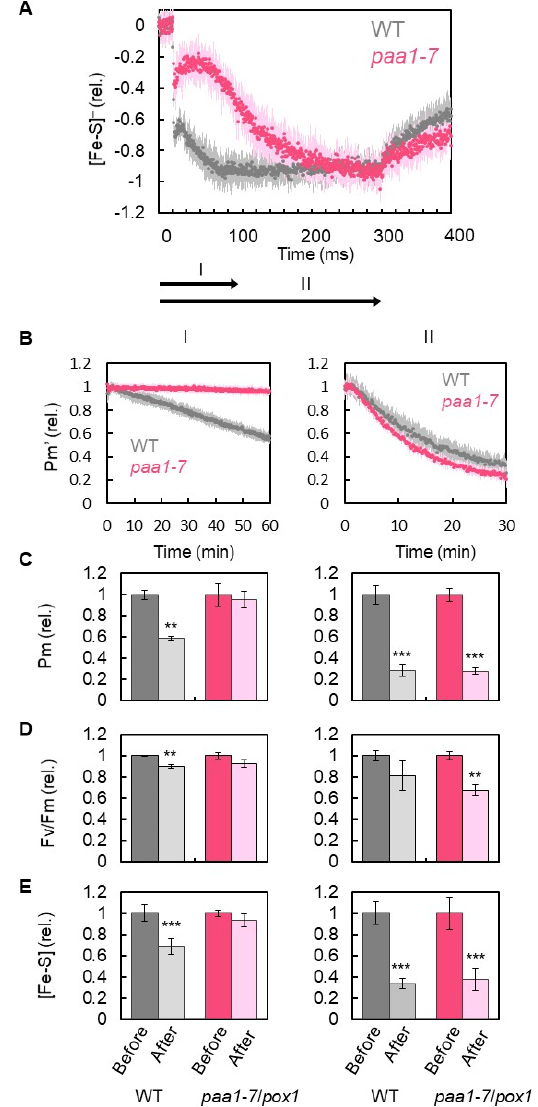
Figure 3. Effects of rSP light illumination and illumination time on the incident photo-oxidizable P700 (Pm’), photo-oxidizable P700 (Pm), maximum quantum efficiency of PSII (Fv/Fm), and amount of Fe/S in wild-type (WT) and paa1-7/pox1 Arabidopsis. The leaves were illuminated every 10 s with short-pulse light of 15,000 µ mol photons m − 2 s − 1 under atmospheric conditions (40 Pa CO 2 / 21 kPa O 2 ) for 30 min. The rSP light illumination started at 0 min. ( A ) The illumination time was set to the two durations, as indicated by the arrows (I, 100 ms; II, 300 ms), based on the reduction kinetics of Fe/S of both WT and paa1-7/pox1 (redrawn from Figure 1, Black, WT; red, paa1-7/pox1 ). In experiments I and II, the parameters Pm’, Pm, Fv/Fm, and [Fe/S] − were analyzed. ( B ) Pm’. Black, WT; magenta, pgr5 hope1 . The values were normalized to the primary values before the rSP light illumination treatment and are shown with standard deviations. The data were obtained from six biological replicates. ( C ) Pm, ( D ) Fv/Fm, and ( E ) Fe/S before and after the rSP light illumination treatments in both WT and pgr5 hope1 were compared. These parameters were evaluated after the illuminated leaves were left for 1 h in the dark. Each value was normalized against the value before the rSP light illumination treatment. ** p < 0.01; *** p < 0.001 (Welch’s t